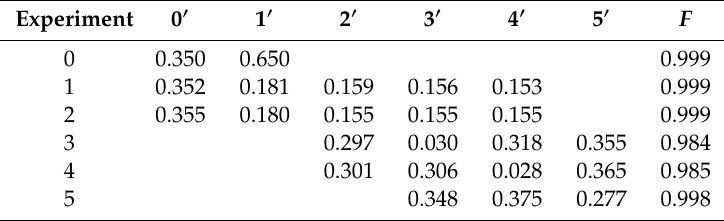
Table 2. Experimental classical characterization results of the selected chip for each input